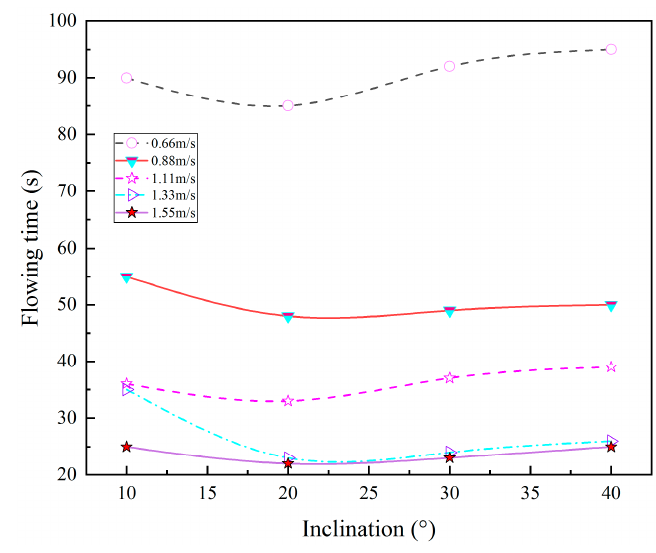
Figure 20. The time required for carrying water by oil with different inclined angles.